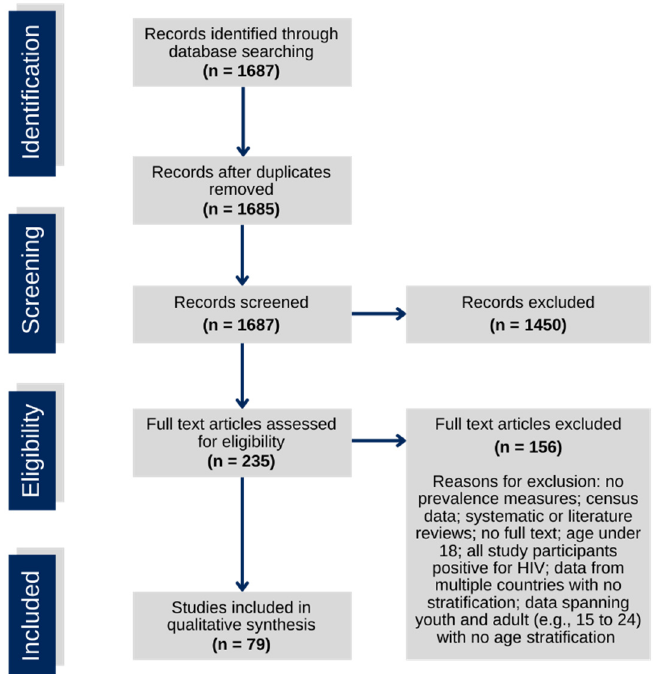
Figure 1. PRISMA flow diagram (‘n’ indicates number of articles).